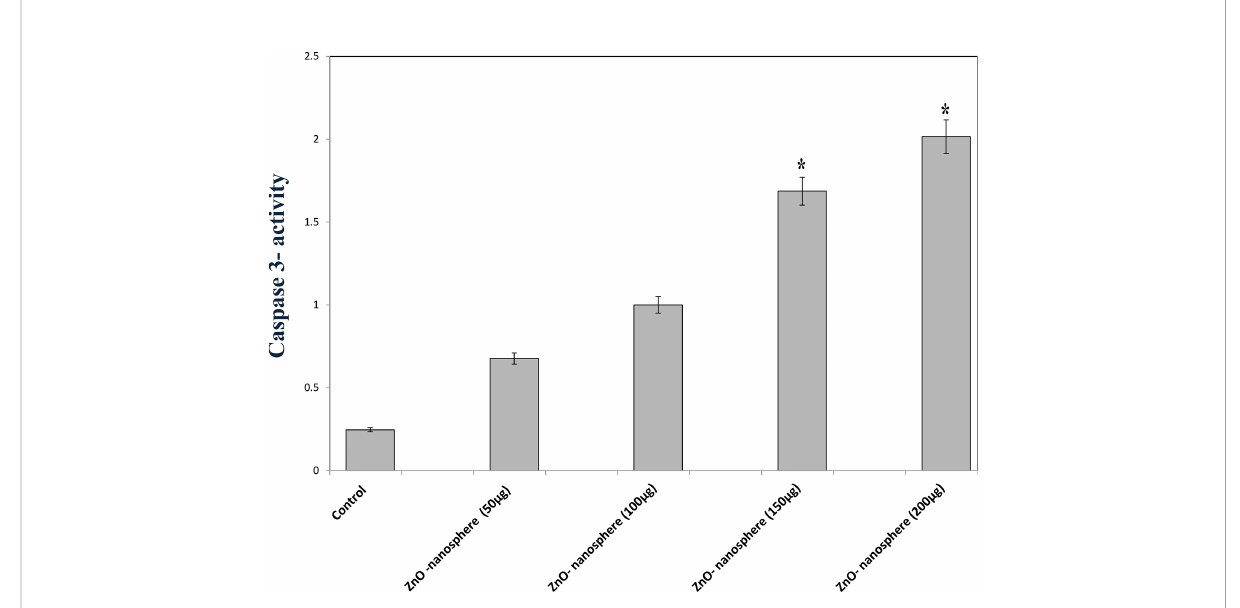
FIGURE 10 Caspase-3 measurement of ZnO nanospheres. *Statistically signi fi cant difference as compared with the controls (P> 0.05 for